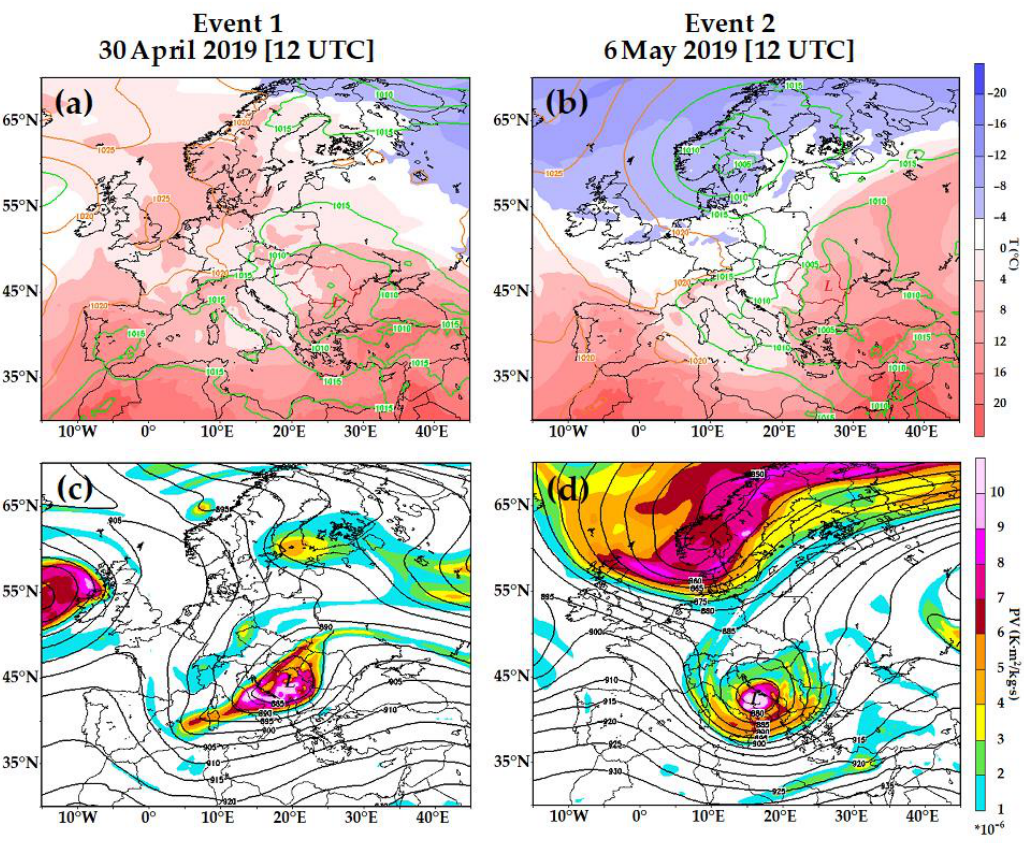
Figure 2. Synoptic context of the convective events derived from ERA5 dataset [51,52]: first row—mean sea level pressure (in hPa) with green contours (low pressure values) and orange contours (high pressure values) and air temperature at the level of 850 hPa (red-blue shades, in ◦ C) ( a ) for 30 April 2019 and ( b ) for 6 May 2019; second row 300 hPa geopotential height (black contours, in gpdam) and potential vorticity × 10 − 6 (shaded areas, in K · m 2 / kg · s) ( c ) for 30 April 2019 and ( d ) for 6 May 2019.